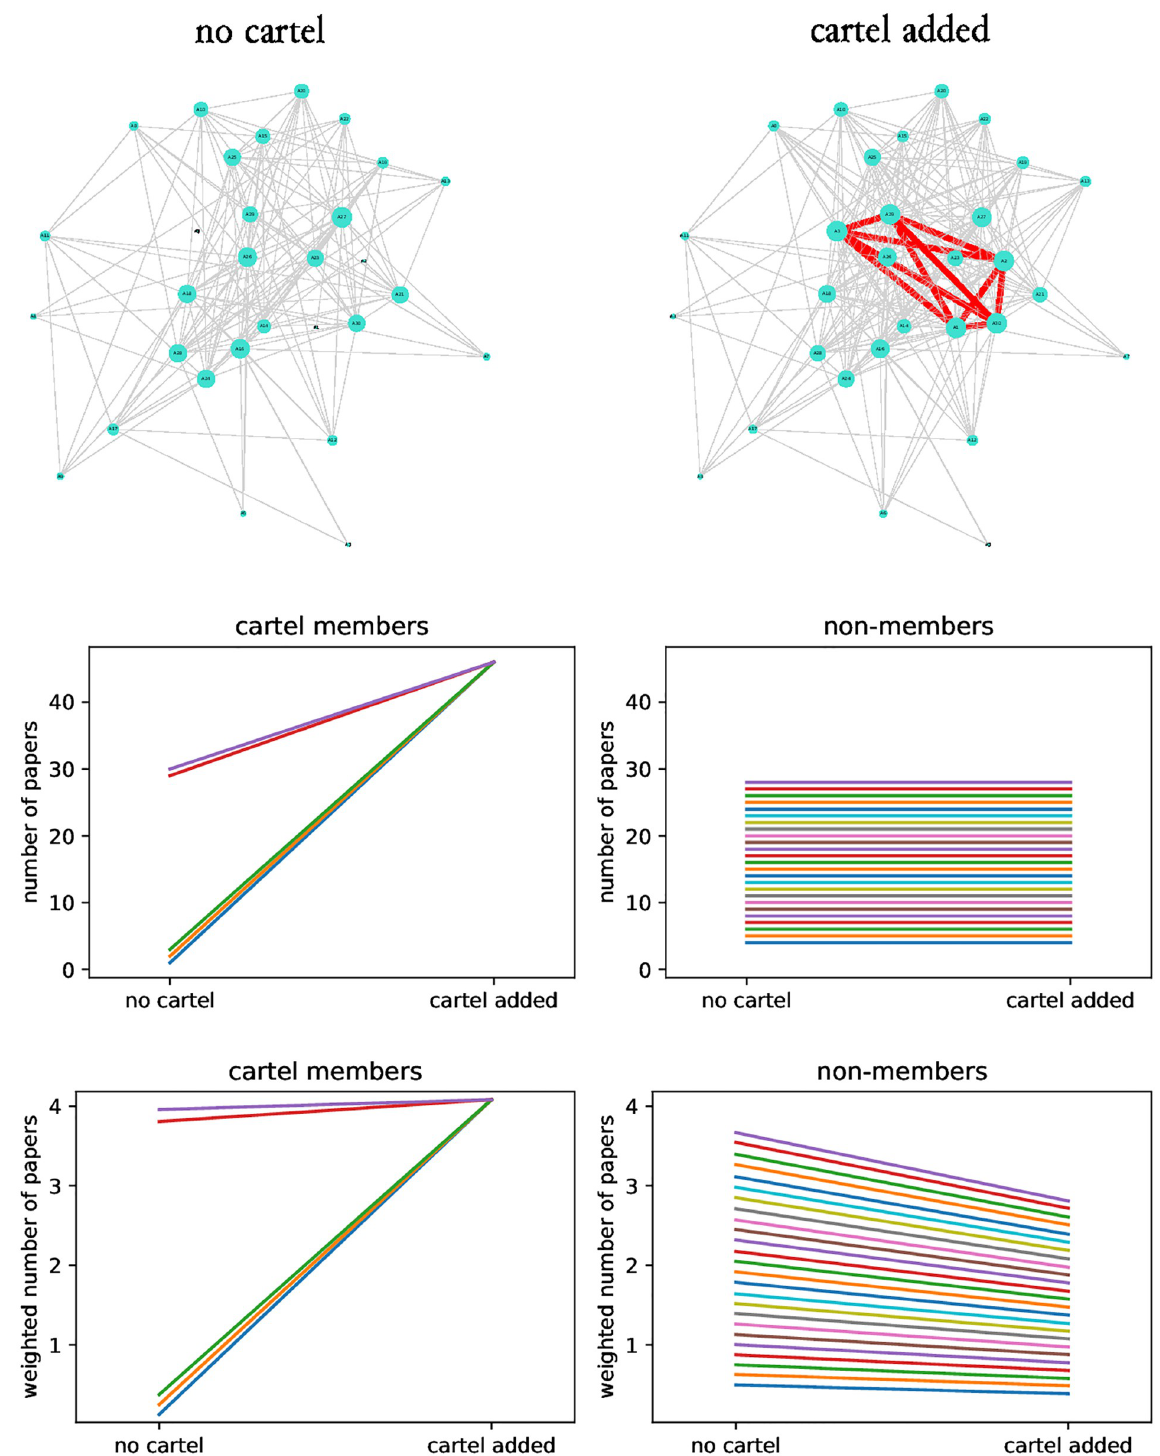
Fig 6. The effect of cartel formation on the productivity of cartel members and non-members: Prior productivity of authors differs. The top panels illustrate the collaboration graph without and with cartel formation. The middle panels show how the number of papers produced by members and non-members changes because of founding cartel. The bottom panels illustrate the same but using the weighted number of papers as a measure of productivity. Collaboration graphs were formed with c = 30, k j = j , p = 60, p c = 1 and κ = {1, 2, 3, 29, 30} (cartel composition illustrate the case when authors of very low and very high productivity form a cartel). Averages of 1000 repetitions are plotted and different colours represent different authors.